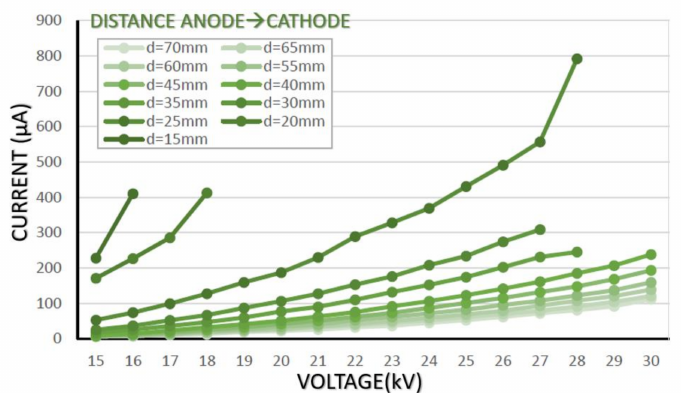
Figure 16. Single thruster (400 mm electrodes): current vs. voltage for different distances between cathode and anode.